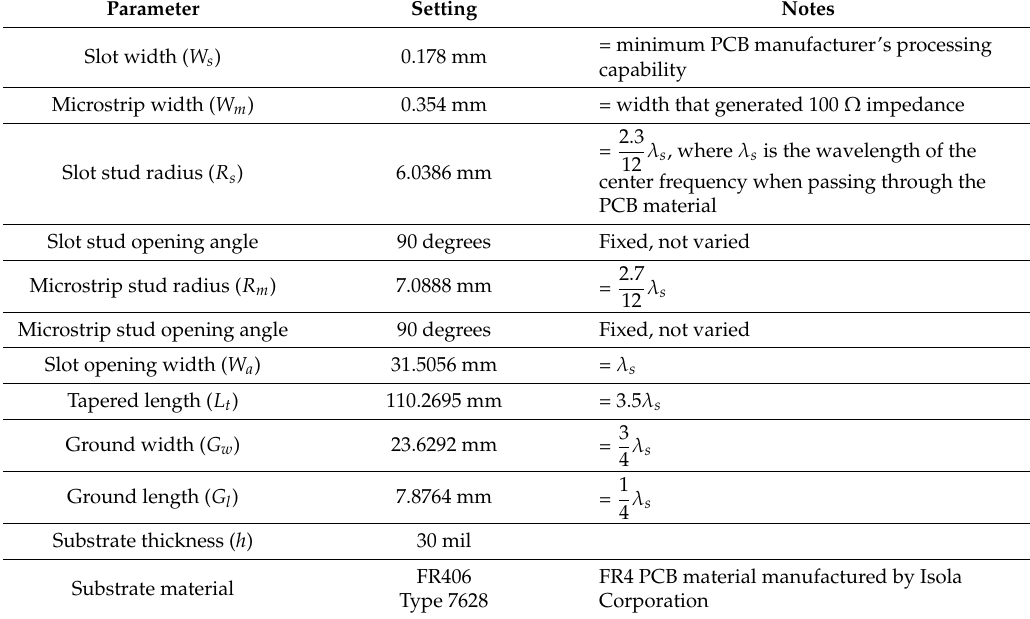
Table 1. Baseline model parameters.